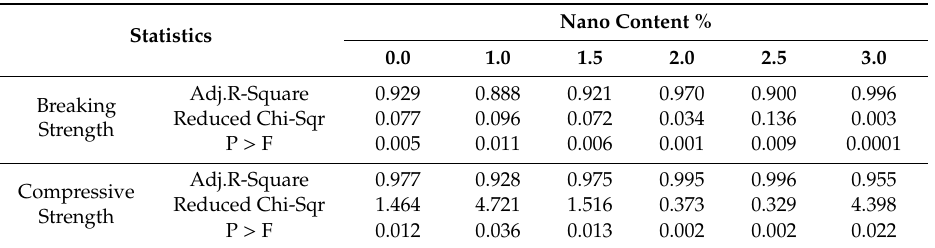
Table 3. Statistical analysis results of strength curve